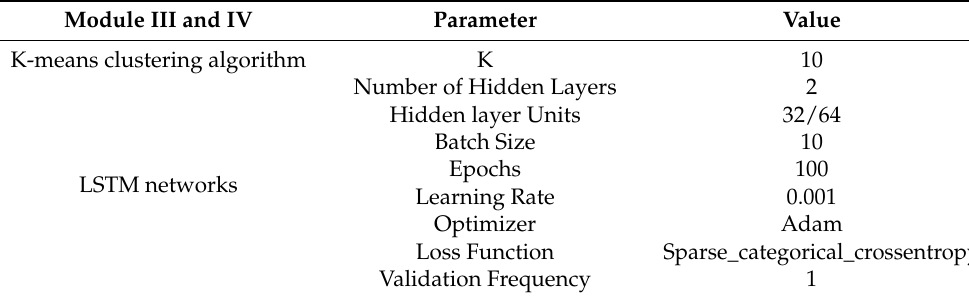
Table 6. The optimal hyper-parameter settings.